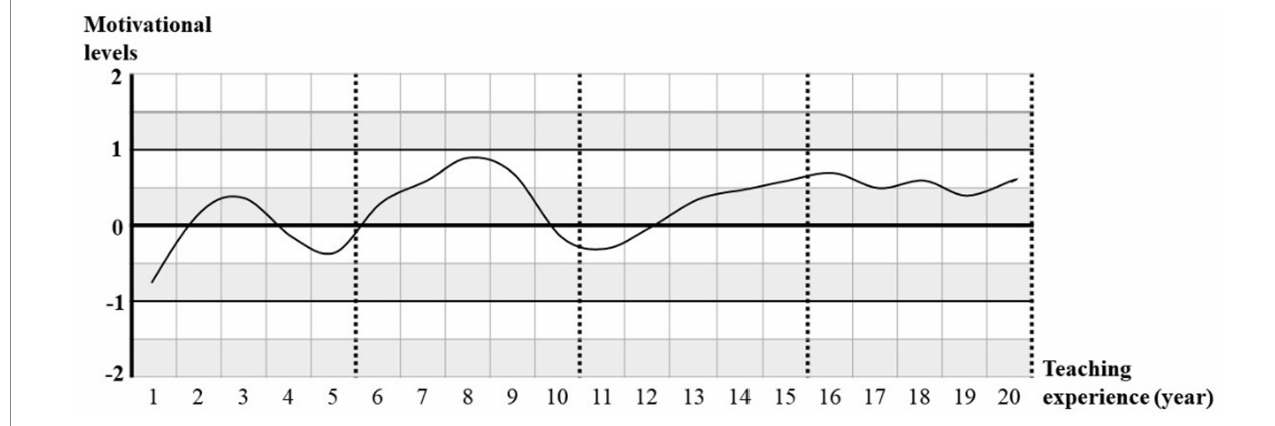
FIGURE. 2 Average curve of EFL teachers’ motivation change. Motivation level 2 = very interesting, 1 = interesting, 0 = neither interesting nor boring, − 1 = not interesting, − 2 = very boring.